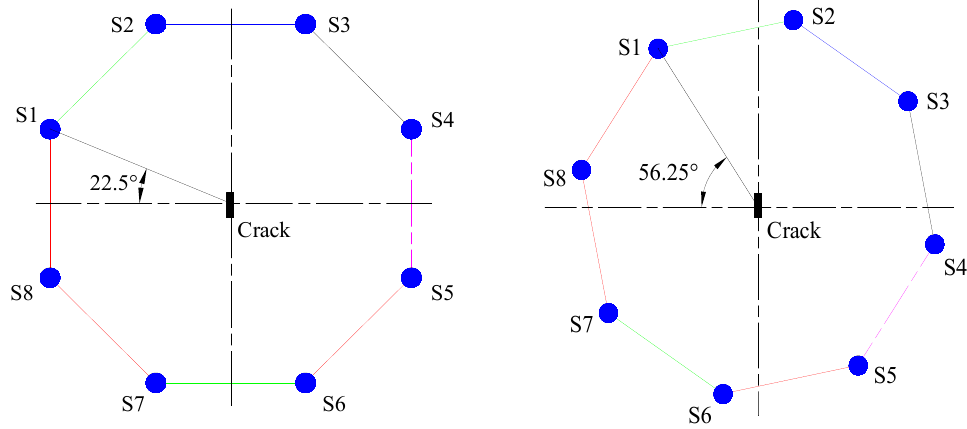
Figure 6. Schematic diagram of sensor distribution with crack inclination angles of 22.5° and 56.25°.